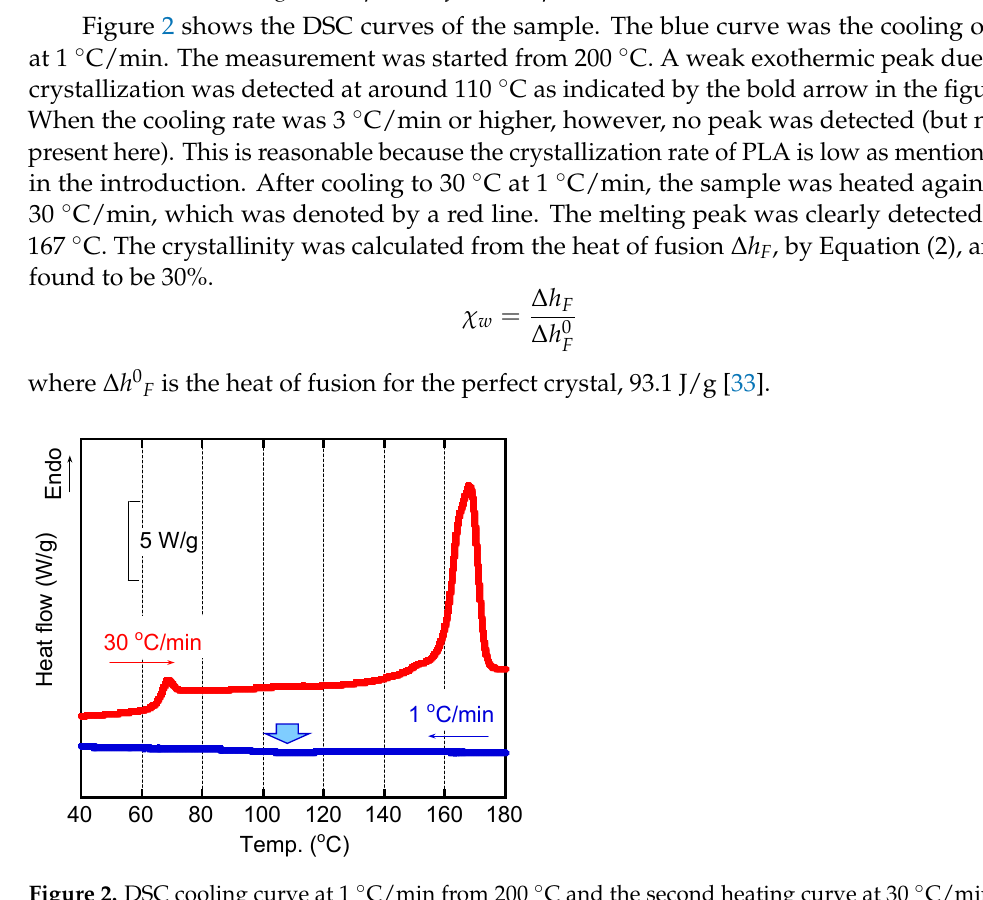
Figure 2. DSC cooling curve at 1 °C/min from 200 °C and the second heating curve at 30 °C/min.